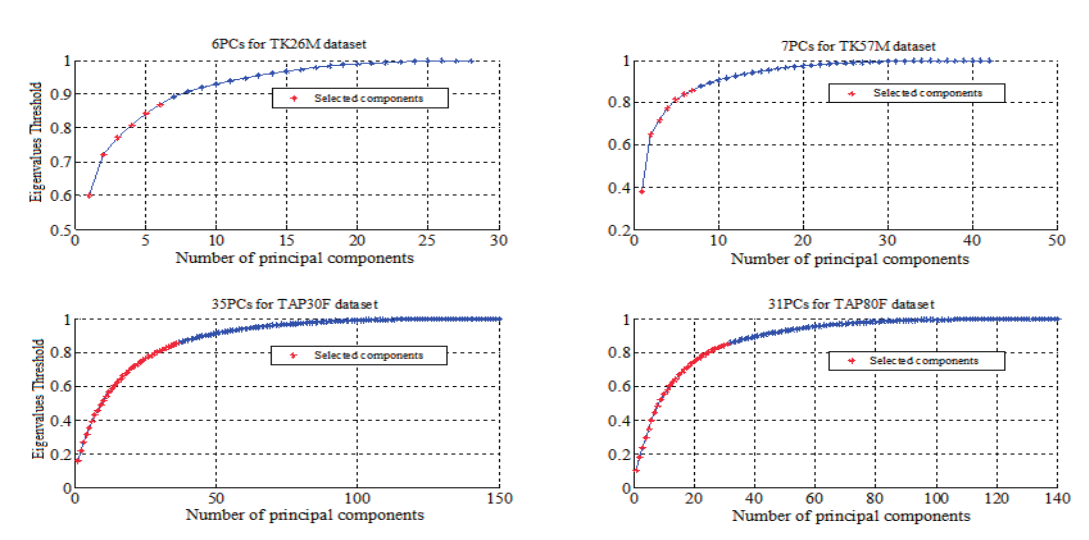
Figure 2. Feature selection by Principal Component Analysis